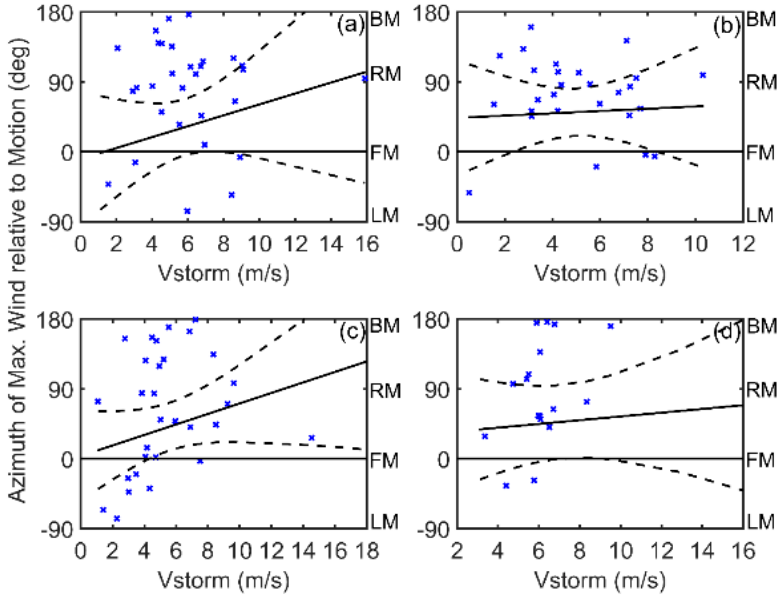
Figure 9. Maximum wind speed position ( θ max ) versus the typhoon translation speed ( V storm ) for ( a ) a tropical storm, ( b ) typhoon, ( c ) severe typhoon, and ( d ) super typhoon, as shown in Figure 3. The black solid and dashed lines represent linear regressions and 95% confidence intervals for the fits, respectively. θ max ( ◦ ) is in the clockwise azimuthal direction relative to the typhoon movement direction. RM indicates that θ max is located on the right side of the TC motion, LM indicates that θ max is located on the left side of the TC motion, FM indicates that θ max is located to the forward of the TC motion, and BM indicates that θ max is located behind the TC motion.